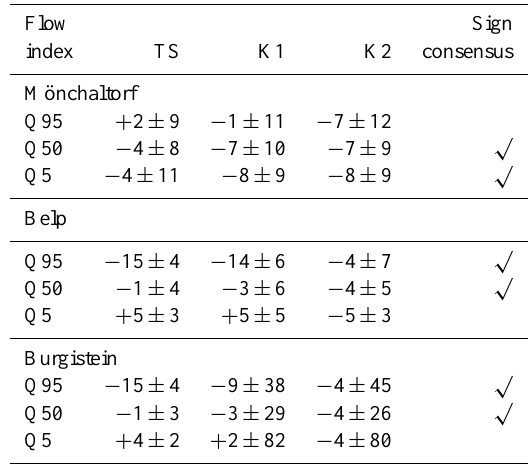
8˚E8˚E 10˚E10˚E Fig. 1: The catchments and gauging sites (triangles) of this study and Figure 1. The catchments and gauging sites (triangles) of this study and their locations in Switzerland. their locations in Switzerland. Table 1. Relative changes in flow quantiles ∗ due to climate change with different uncertainty assessment 2Wednesday, September 19, 2012